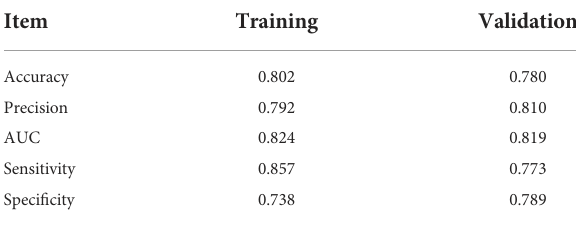
TABLE 4 Evaluation of the DT model in the training and validation